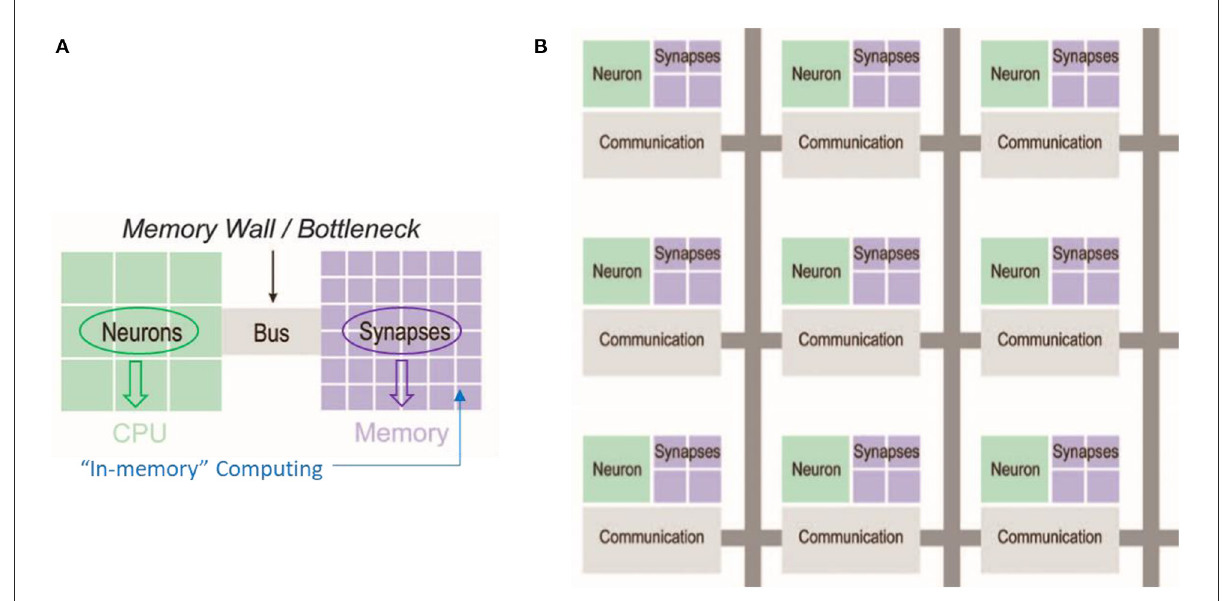
FIGURE1 (A) traditional Von-Neumann architecture (B) Brain-inspired architecture (Burr et al., 2015; Silver et al., 2016).